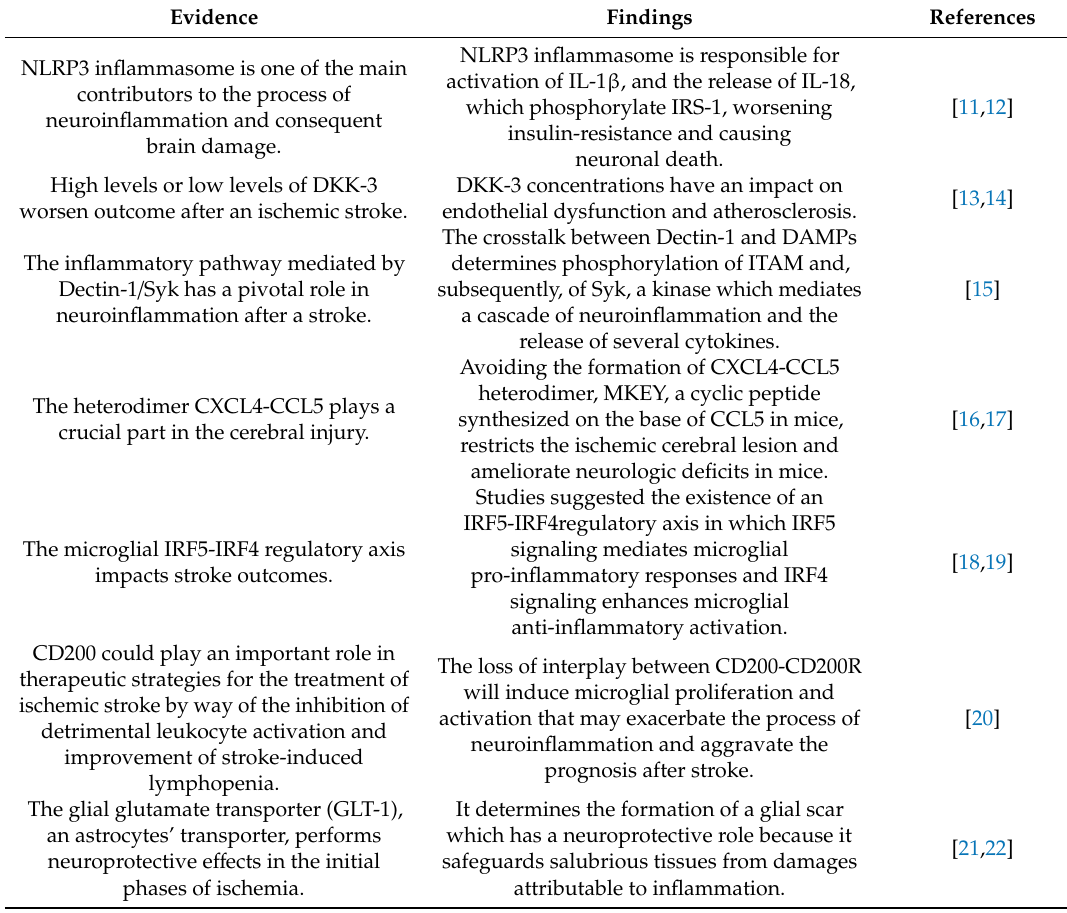
Table 1. Key biological molecular patterns of innate immune system implied in